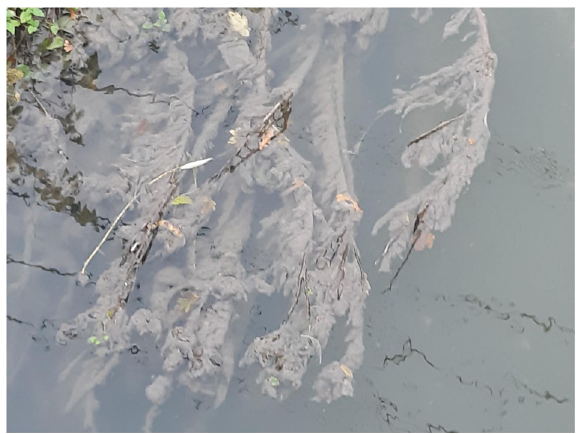
Fig. 6 Photograph of sewage fungus. Sewage fungus resulting from 30 day spill of untreated sewage from WWTP2 in November